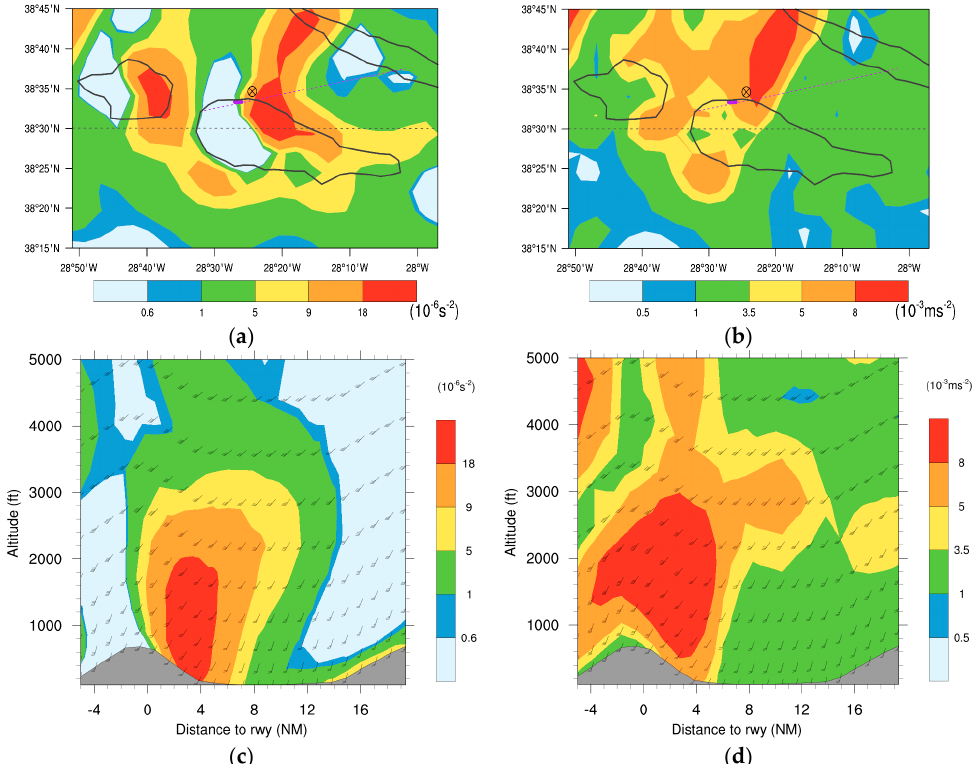
Figure 14. Horizontal variation of ( a ) Ellrod TI2 and ( b ) CAT1 at 66 m for Flight 1. Dotted pink line shows aircraft trajectory and pink bar locates the aerodrome. The circled “x” mark identifies the approximate aircraft position at 66 m. Cross-sectional variation of ( c ) Ellrod TI2 and ( d ) CAT1.